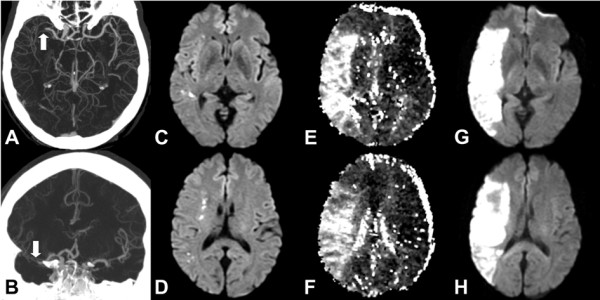
61 year old male presenting with left facial droop and dysarthria. Initial imaging studies were performed 6 hours after witnessed onset of speech difficulties. However, patient noted symptoms suggestive of facial weakness 12 hours prior to imaging. A &B. CTA demonstrates a proximal right MCA occlusion (white arrows). C &D. Initial DWI shows multiple punctate foci of diffusion abnormality consistent with a small acute infarct. E &F. Time to peak (TTP) MR perfusion map demonstrates a large volume of underperfused area involving the majority of the right MCA territory and consequently a large diffusion/perfusion mismatch. The patient did not undergo thrombolytic therapy because of the uncertain time between stroke onset and presentation. G &H. Follow-up MRI shows an infarction involving the majority of the right MCA territory. Whole brain map volume measurements for this patient are: DWI: 2.1 ml; MTT: 117 ml (mismatch: 115.4 ml); TTP: 28 ml (mismatch 25.9 ml).